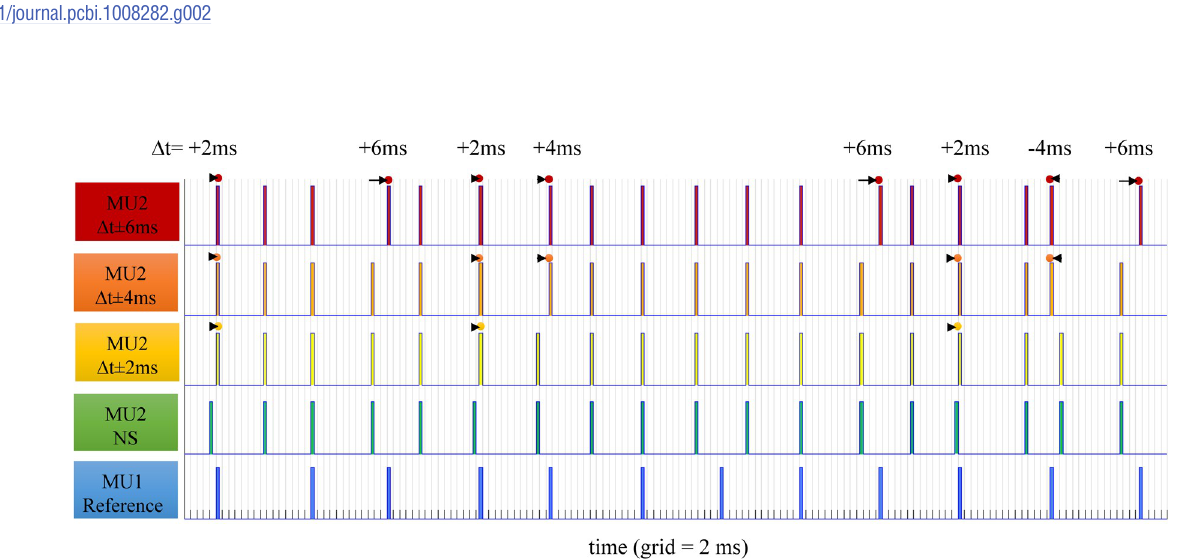
PLOS Computational Biology | https://doi.org/10.1371/journal.pcbi.1008282 April 26,